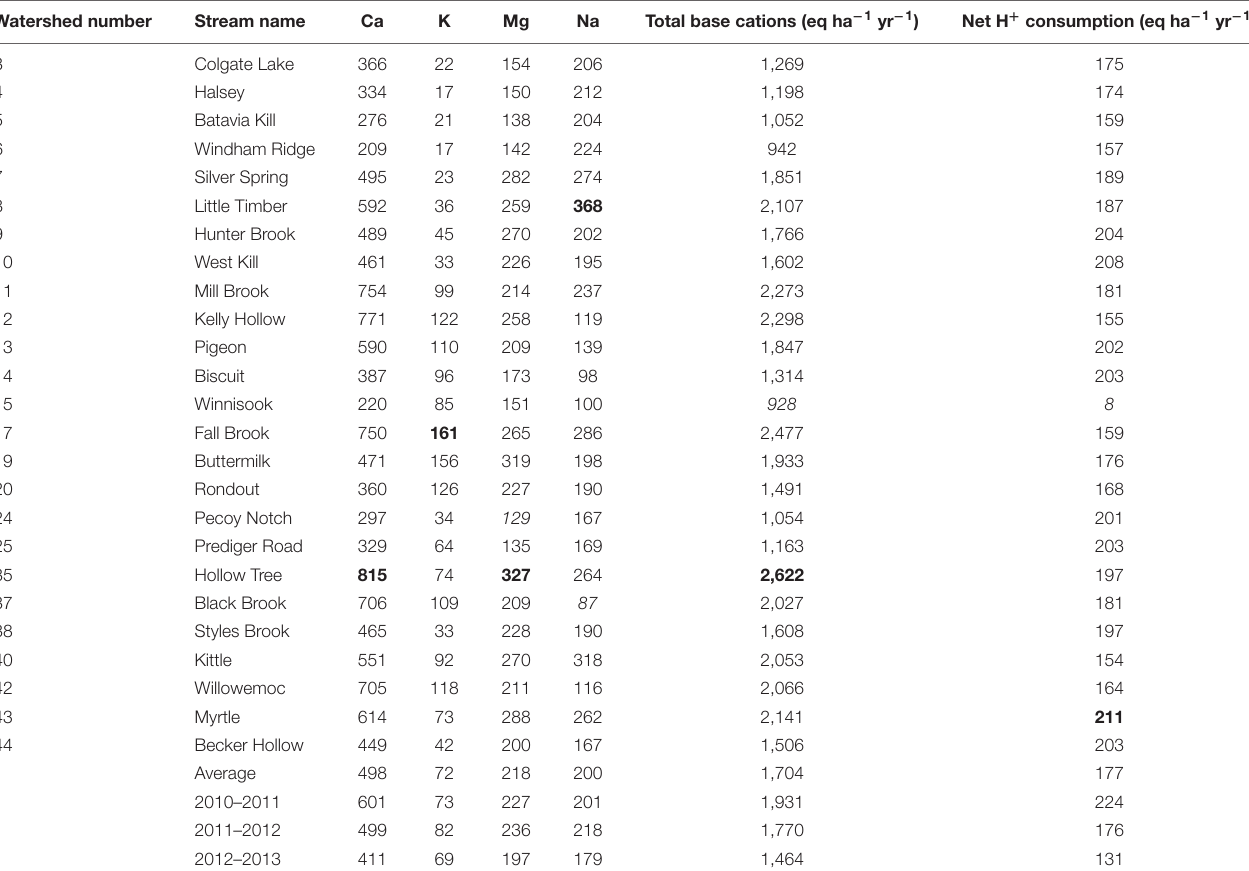
TABLE 4 | Average annual net geochemical release rates for base cations for all